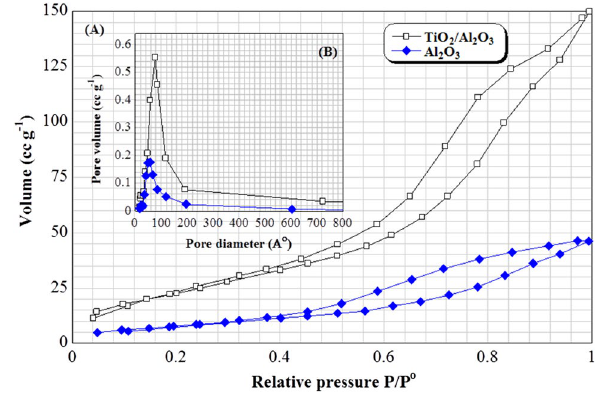
Fig. 2 a Adsorption/desorption isotherm for bar alumina disc and TiO 2 / Al 2 O 3 thin films and b pore size distribution of alumina disc and TiO 2 /Al 2 O 3 thin films